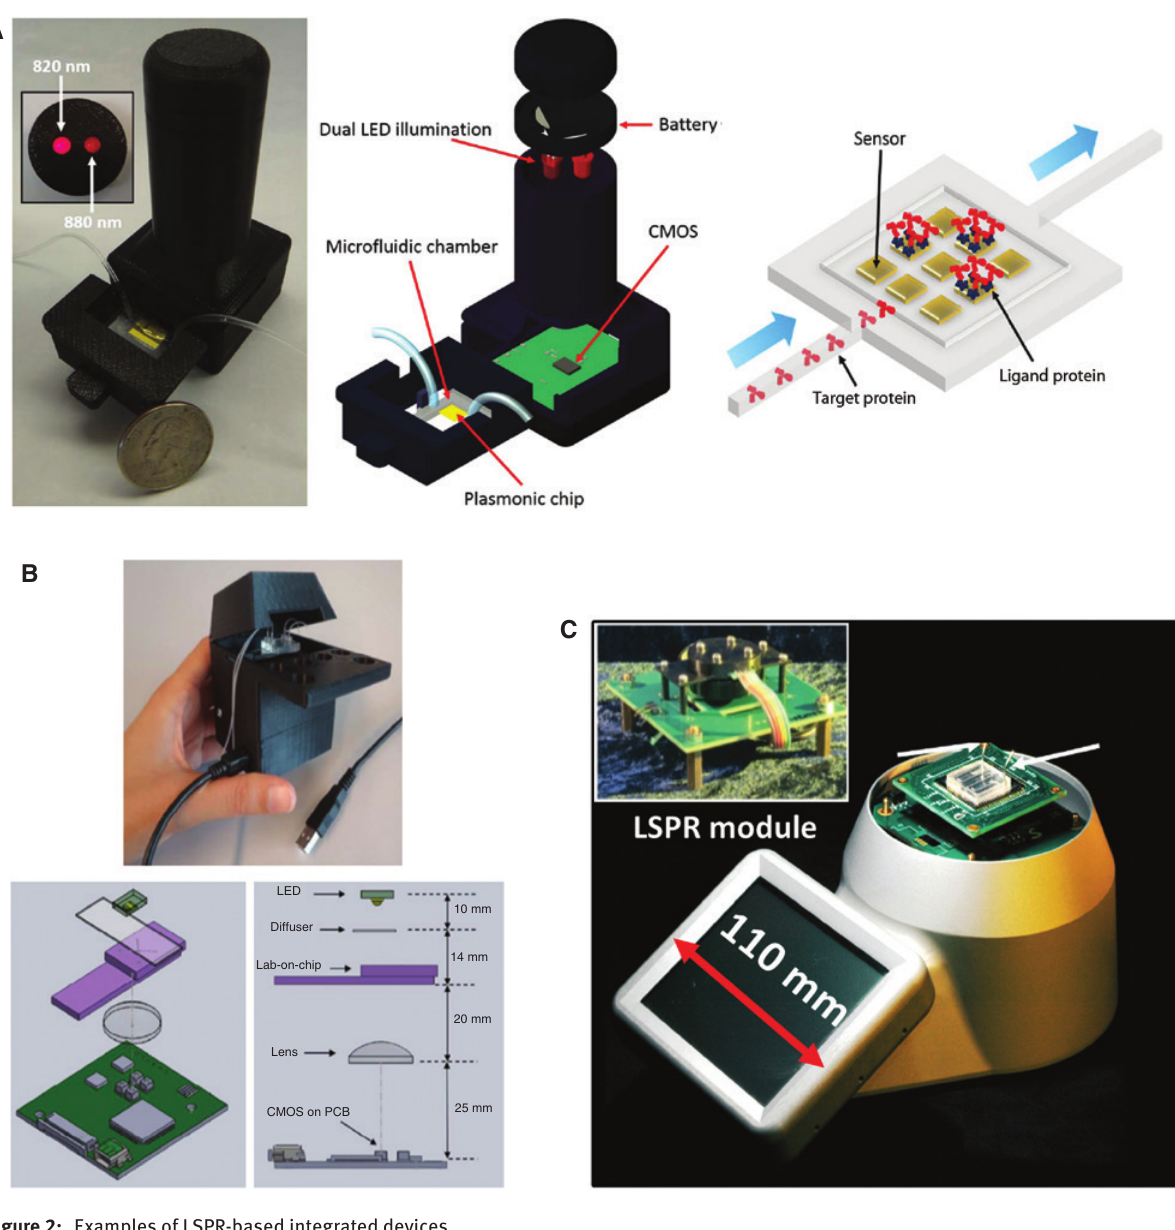
Figure 2: Examples of LSPR-based integrated devices. (A) Plasmonic biosensor platform using dual-color lens-free on-chip imaging configuration. Two LEDs employed for the